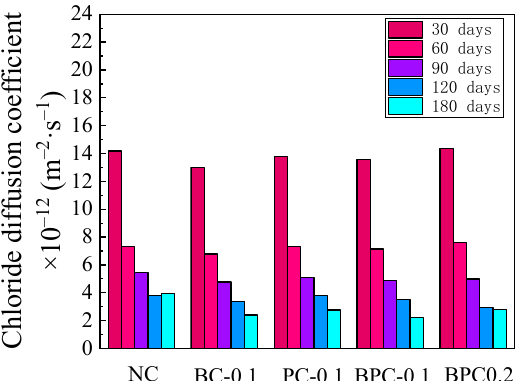
Figure 6. Apparent chloride diffusion coefficient. Table 5. Fitting results of material characteristic parameters.